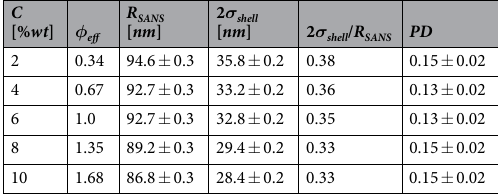
Table 2. Summary of the properties of the Hm-Dm mixture of microgels obtained from SANS experiments under ZAC conditions at all concentrations investigated. Shown are the number-averaged values of the overall radius R SANS = R + 2 σ shell , the fuzzy shell 2 σ shell , the size ratio 2 σ shell / R SANS , and the polydispersity PD as obtained from a fit of the fuzzy sphere model to the experimental data for T = 15 °C.